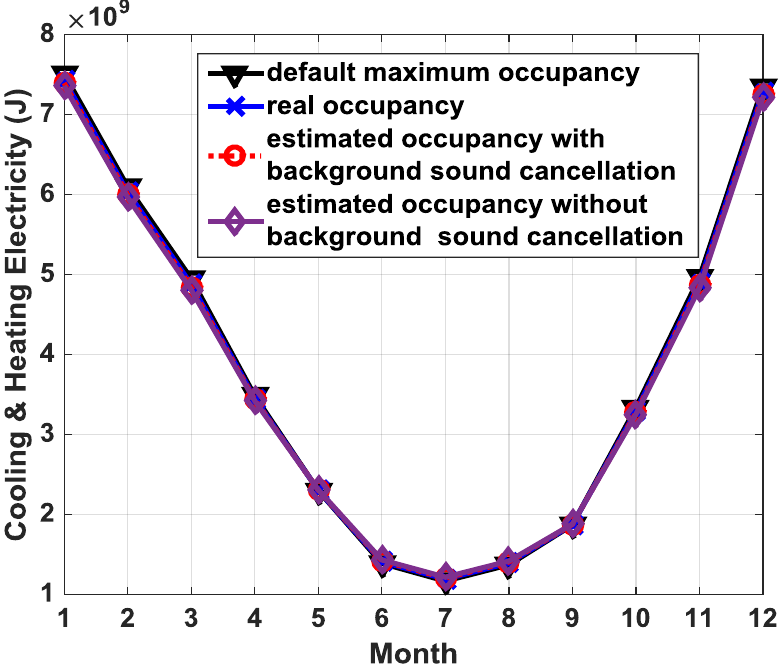
Figure 7. Simulation results of monthly heating and cooling electricity for a one-year period.